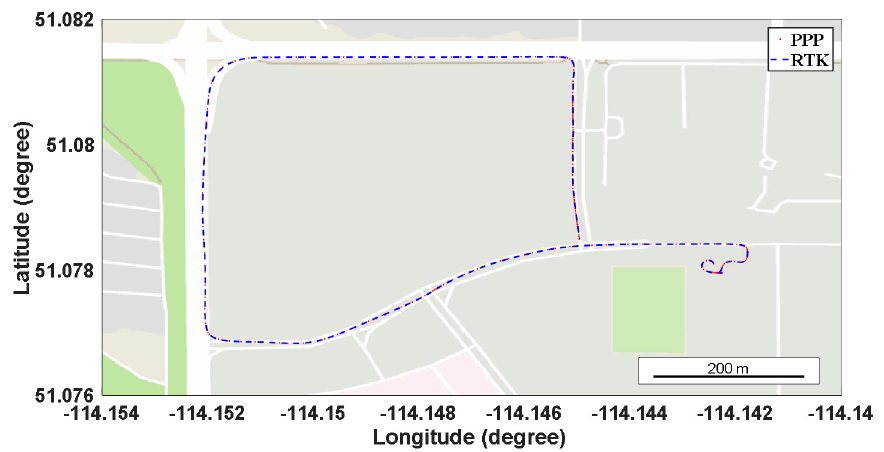
Figure 9. Trajectory of the kinematic PPP testing around the University of Calgary, Canada.